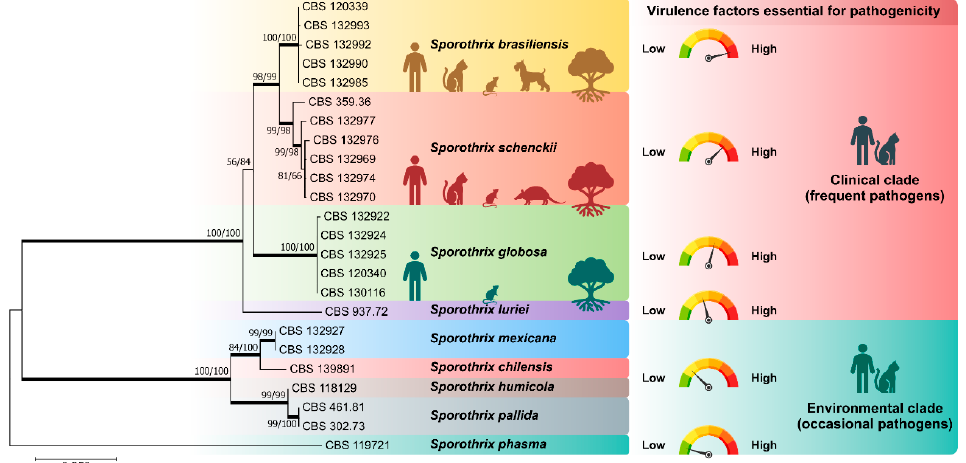
Figure 1. Phylogenetic analysis of the main members of medical relevance in the genus Sporothrix using sequences from the partial calmodulin-encoding gene (exons 3–5) and the ITS region (ITS1/2+5.8s). In the clinical clade, S. brasiliensis is highly virulent for the warm-blooded vertebrate host, followed by S. schenckii , S. globosa , and S. luriei . In the environmental clade, S. chilensis , S. humicola , S. mexicana , and S. pallida are occasional pathogens with mild-pathogenic potential to mammals. Sporothrix phasma , a species with no virulence to mammals, was used as an outgroup in the phylogenetic analysis. Numbers close to the branches represent bootstraps values (ML/NJ).